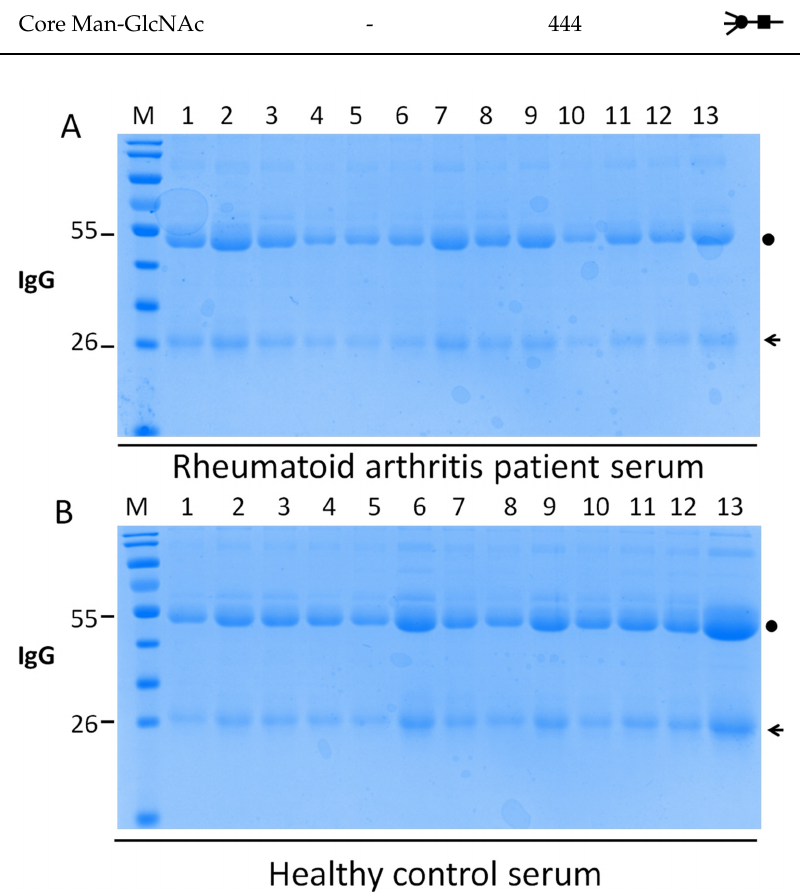
Figure 1. Purity assessment of immunoglobulin G (IgG) from human serum. IgG was purified by protein G affinity chromatography in the serum of rheumatoid arthritis patients ( A ) and healthy controls ( B ), and the heavy chain (black dot) and light chain (arrow) of IgG were separated. Sodium dodecyl sulphate–polyacrylamide gel electrophoresis was performed to determine the purity.